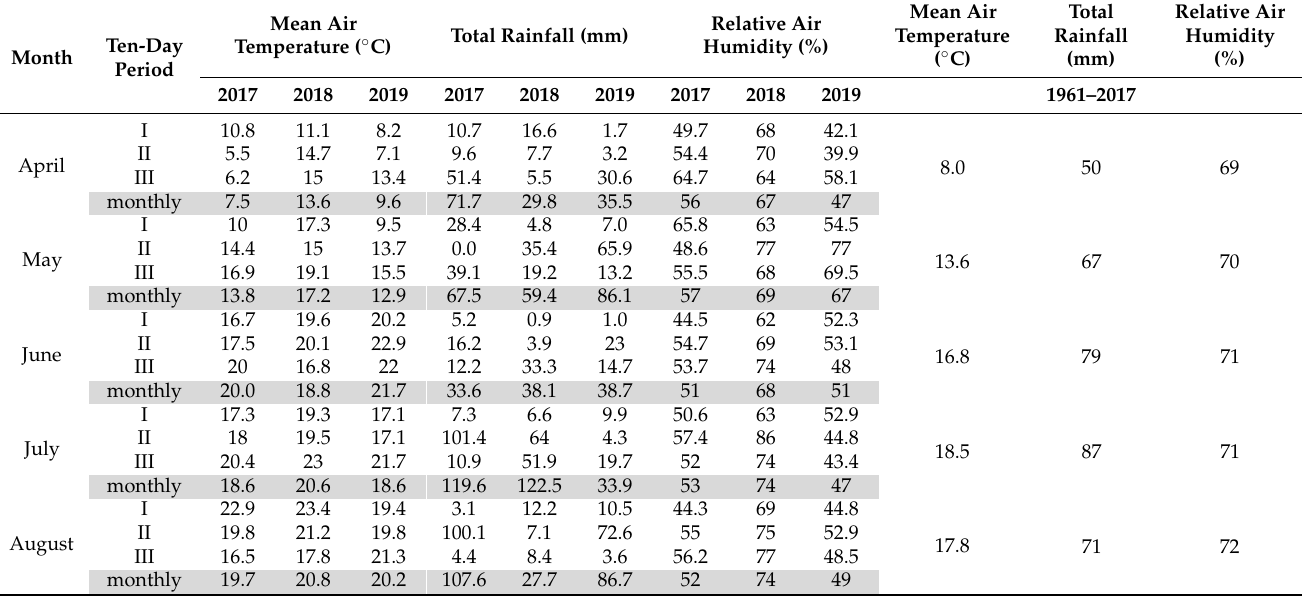
Table 3. Mean air temperature, total rainfall and relative air humidity during the growing seasons in the years 2017–2019 at the Experimental Station in